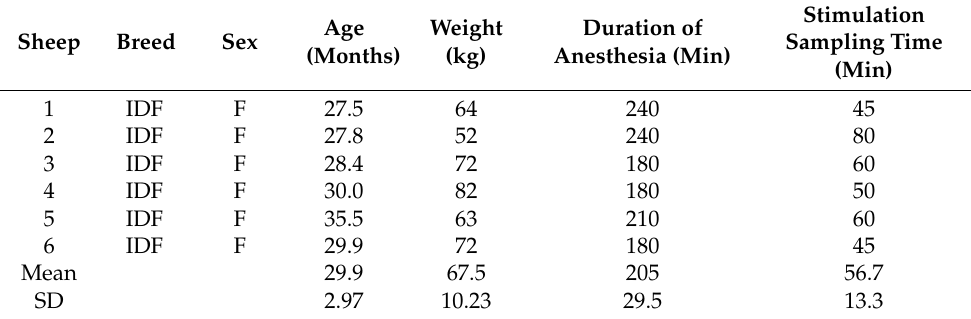
Table 1. Characteristics of the 6 included sheep.